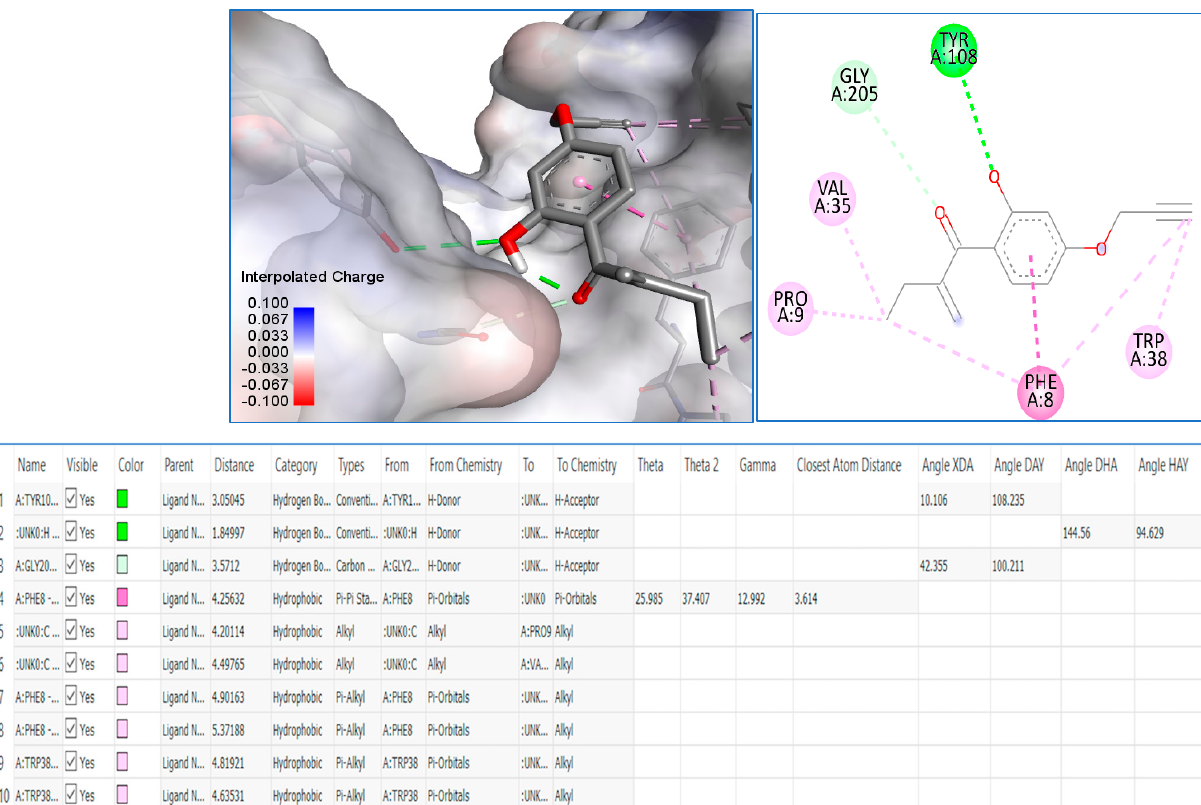
Figure 3. Molecular modeling of compound 8 with glutathione S-transferase active